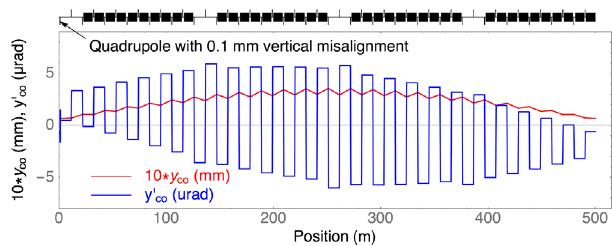
FIG. 9. Vertical and horizontal closed orbit where two opposite positions in the ring have vertical magnetic fields and vertical quadrupole